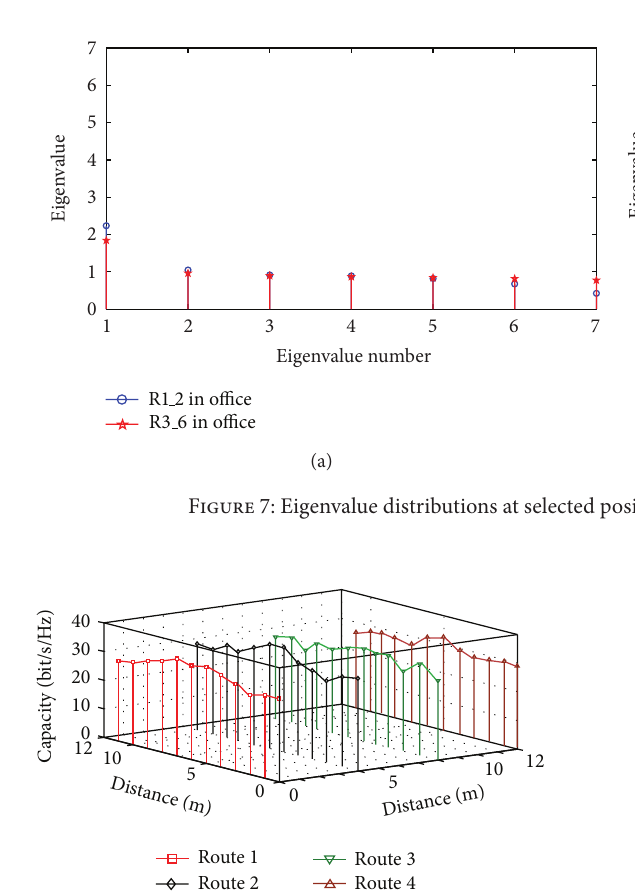
Figure 8: Capacity coverage of D-MIMO system in office scenario.